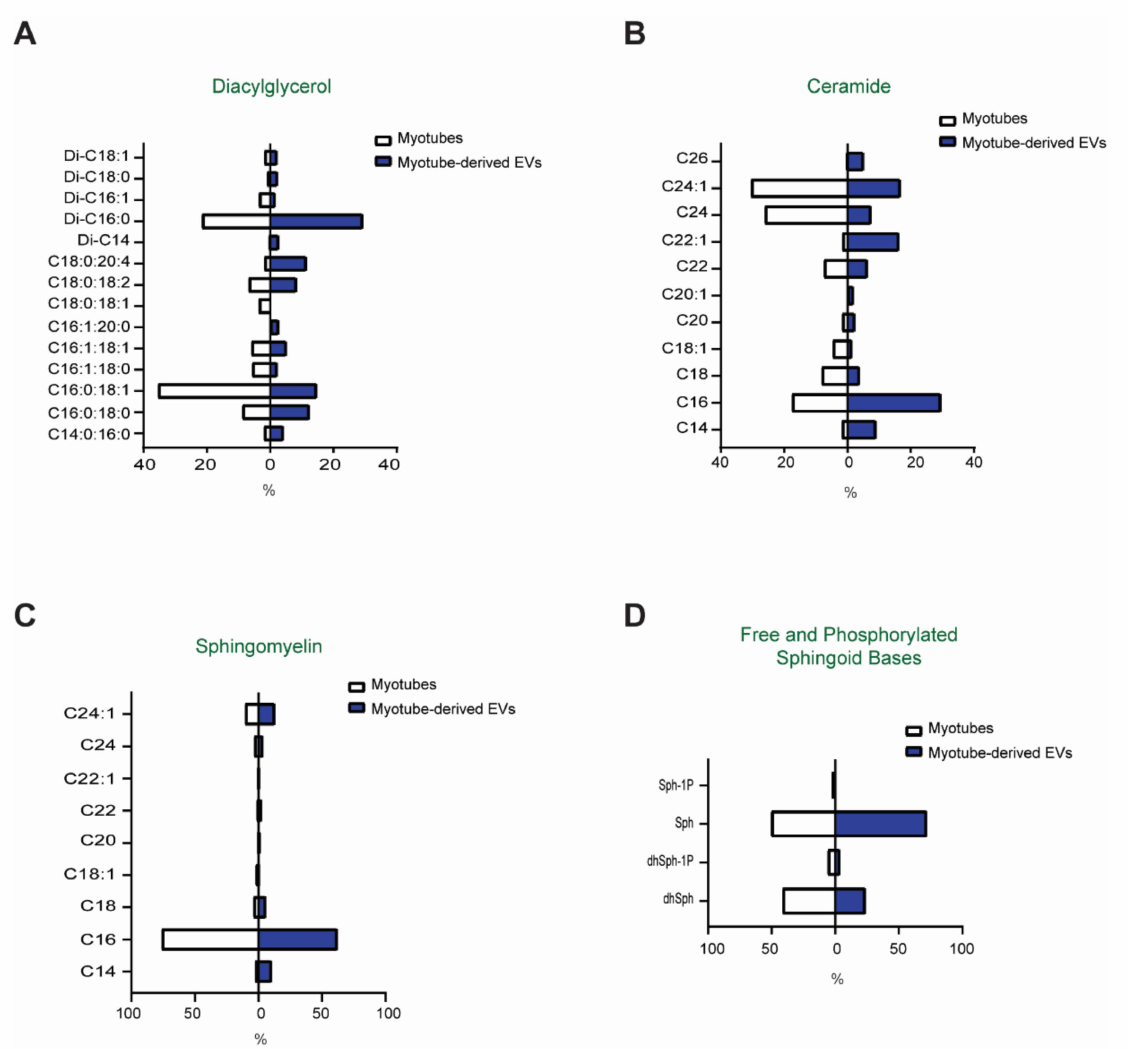
Figure 2. Lipid composition of the myotubes and their secreted EVs: ( A )—diacylglycerol; ( B )—sphingomyelin; ( C )— ceramide; and ( D )—free and phosphorylated sphingoid bases. Data are presented as percent enrichment in specific species ( n =